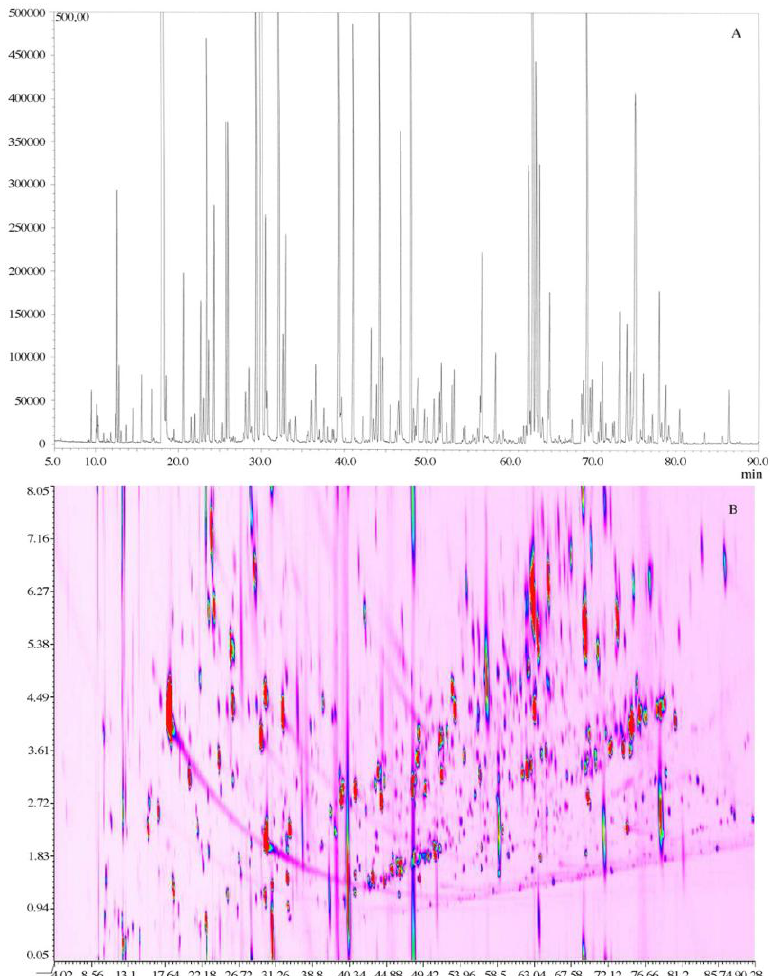
Figure 8. GC-O chromatogram ( A ) and GC × GC-O 2D plot ( B ) of a commercial perfume achieved without ( A ) and with ( B ) cryogenic modulation (reprinted from [29] with permission from